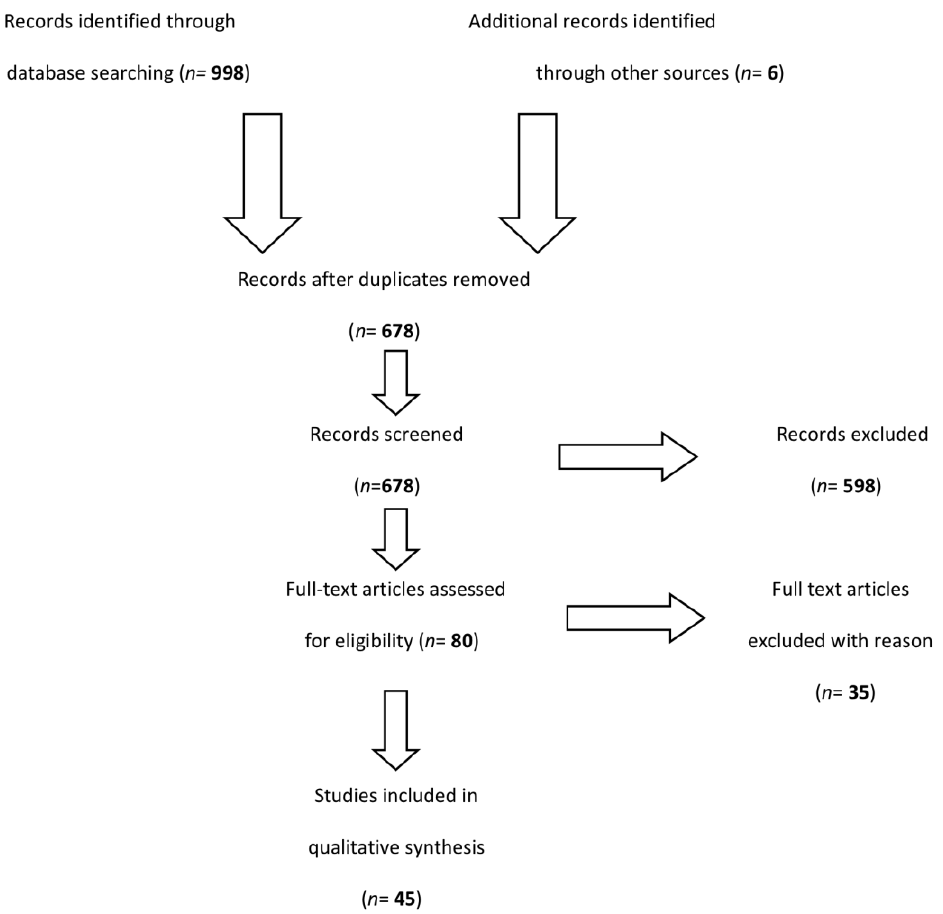
Figure 1. Search strategy and study selection.